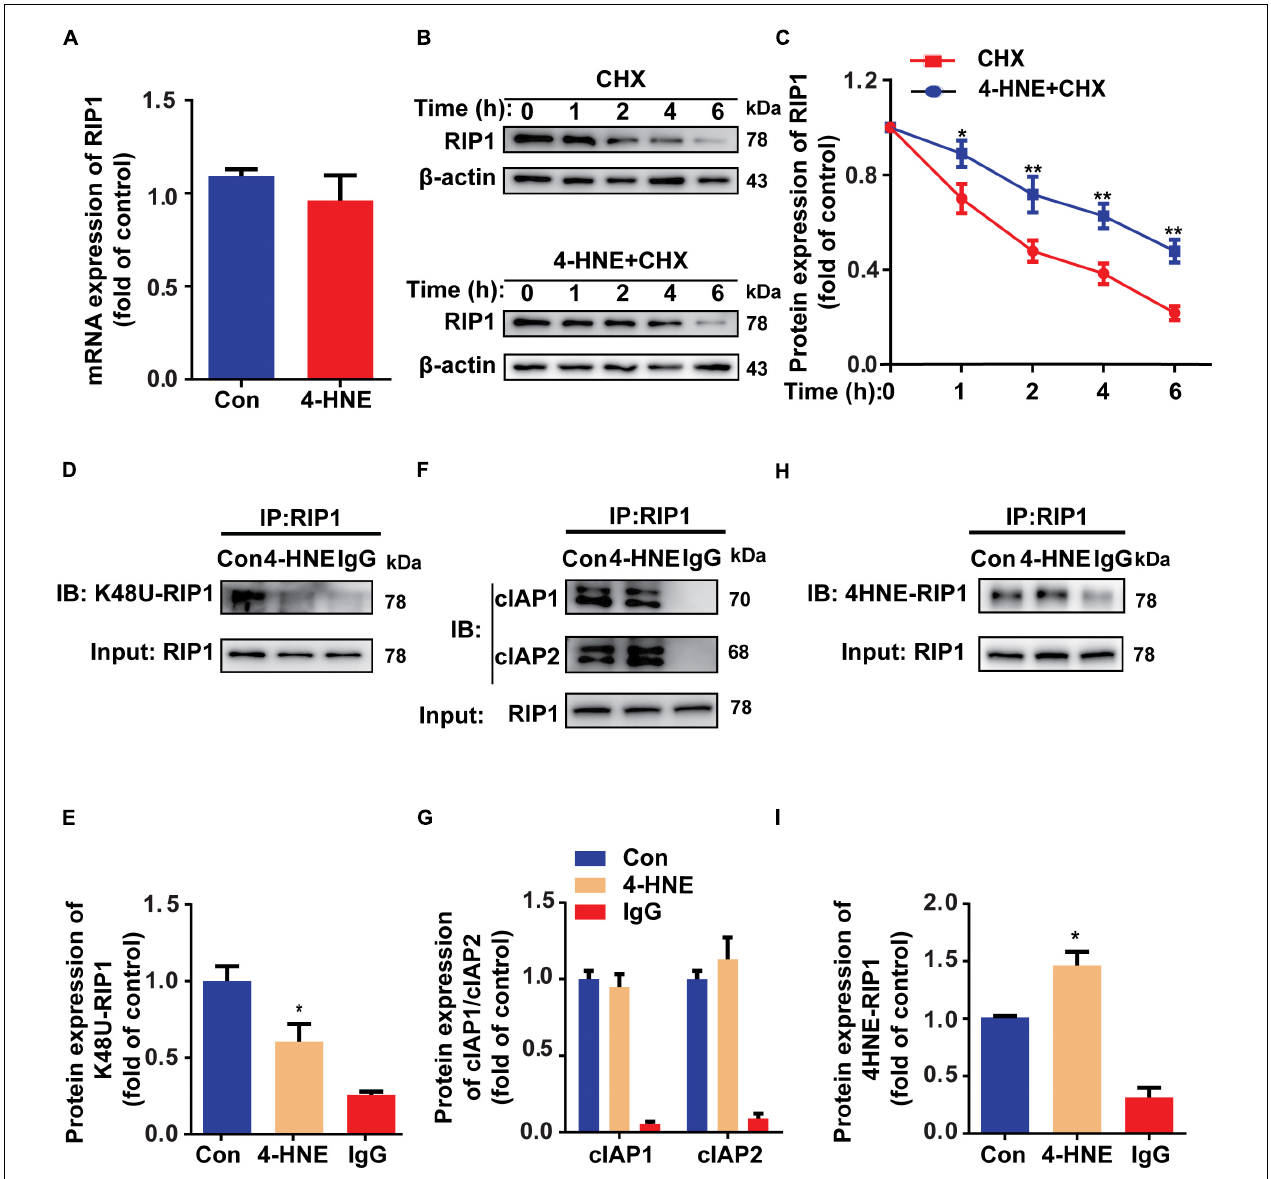
FIGURE 6 | 4-Hydroxy-2-non-enal reduces the ubiquitin-dependent degradation of RIP1. (A) RIP1 mRNA expression in H9c2 tested by quantitative real-time polymerase chain reaction ( n = 5). (B,C) Protein expression of RIP1 in H9c2 cells treated with cycloheximide (CHX) and 4-HNE detected by Western blot ( n = 5). (D,E) Co-immunoprecipitation using anti-RIP1 antibody showed the K48 ubiquitination of RIP1 ( n = 3). (F,G) Co-immunoprecipitation using anti-RIP1 antibody to detect combination between RIP1 and cIAP1 or cIAP2 ( n = 3). (H,I) Co-immunoprecipitation using anti-RIP1 antibody to detect the combination between RIP1 and 4-HNE ( n = 3). * p < 0.05 vs. control group, ** p < 0.01 vs. control